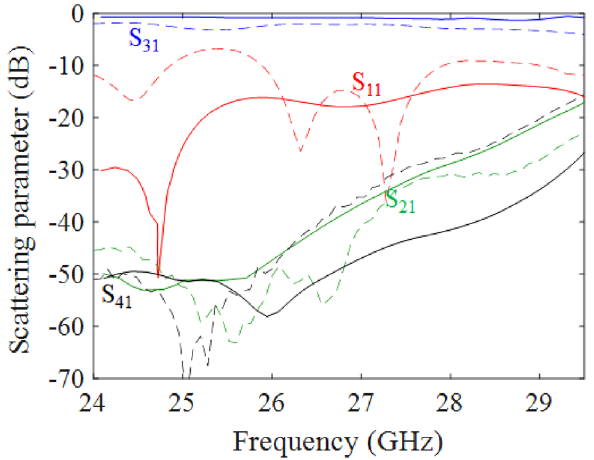
Figure 11. Simulated (continuous lines) and measured (dashed lines) scattering parameters of the PTD- Symmetric ELC using grounded-coplanar waveguide substrate-integrated waveguide transition for excitation at Port 1.